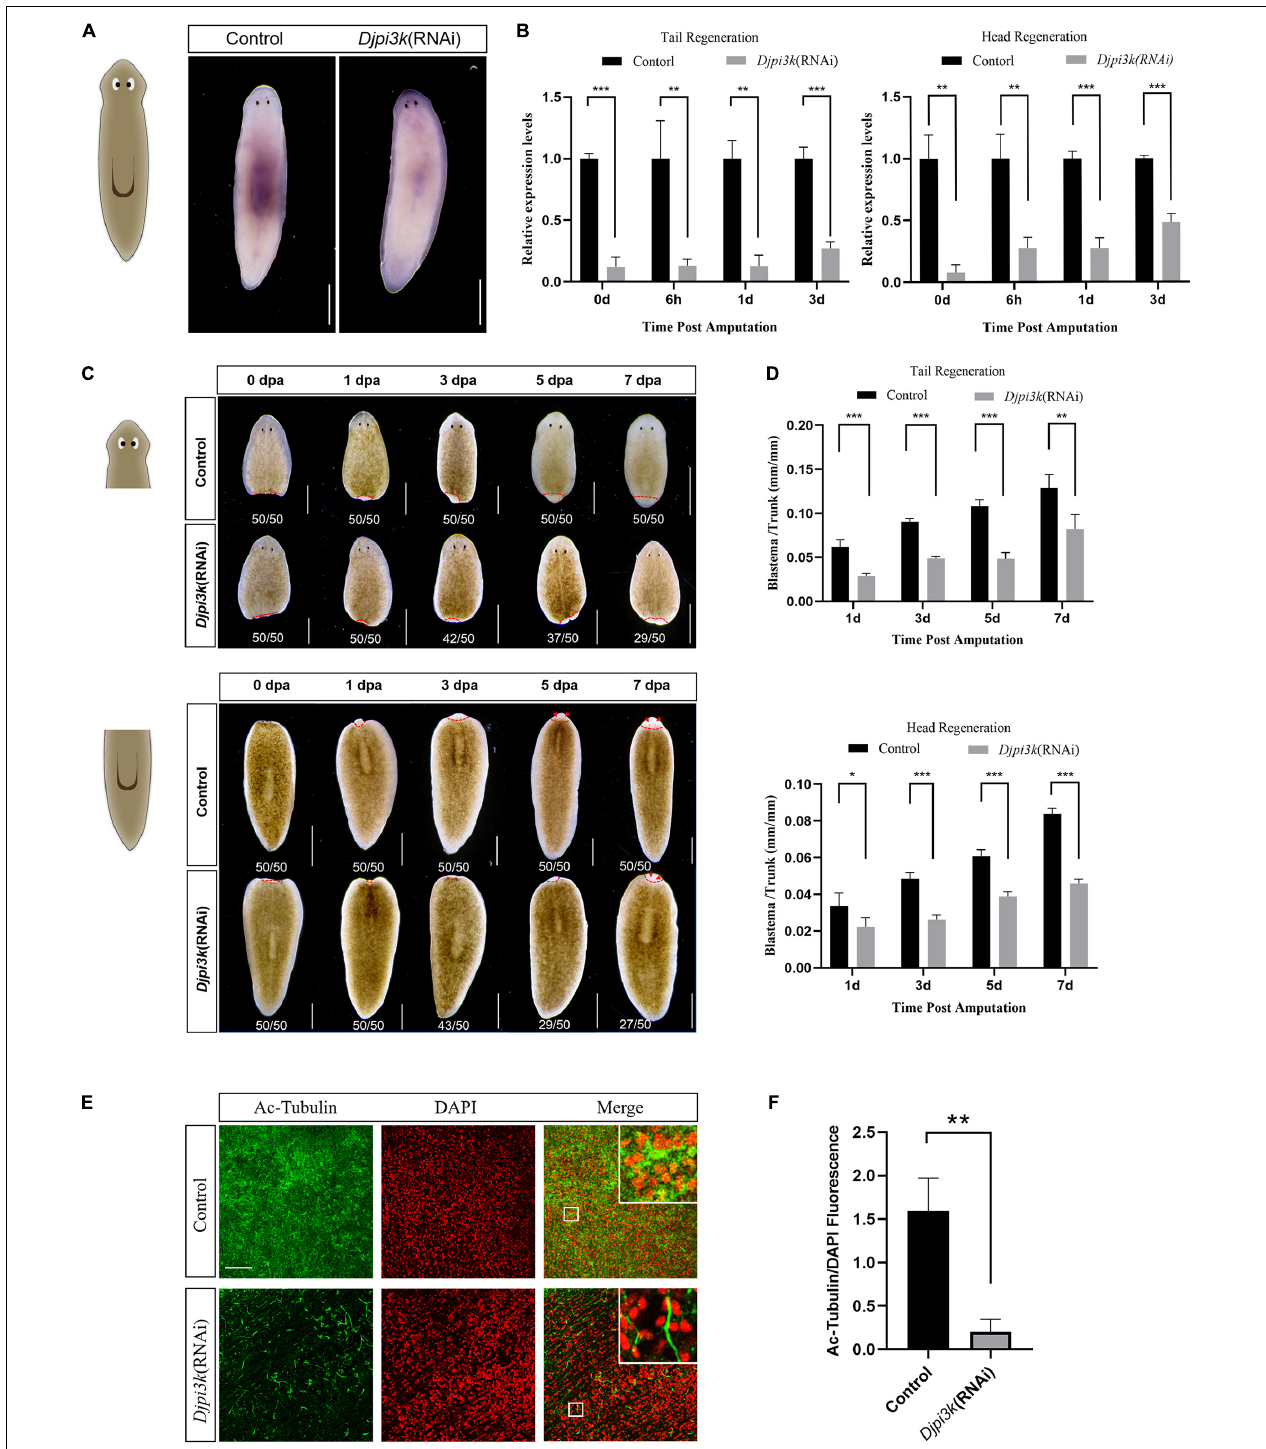
FIGURE 4 | Effect of Djpi3k RNAi knockdown on planarian regeneration and homeostasis. (A) RNAi efficiency was verified in intact animals by WISH using an antisense Djpi3k probe. Scale bar = 1 mm. (B) RNAi efficiency was examined during planarian regeneration by qRT-PCR assay. ** P < 0.01 and *** P < 0.001, by the Student’s t -test. (C) Dorsal images of regenerating trunk fragments from the control and Djpi3k (RNAi) animals at 0, 1, 3, 5, and 7 days post amputation. Newly-regenerated photoreceptors are indicated with red arrows. Scale bar = 1 mm. (D) Quantification analysis of blastema growth. The length of the regenerated blastema was measured and normalized to the whole-body length of the trunk. * P < 0.05, ** P < 0.01, and *** P < 0.001, by the Student’s t -test. (E) Immunostaining of the ventral cilia using an anti-Ac-Tubulin antibody (green). DAPI is used to label the nucleus (red). Magnified images are shown in the right corner. Scale bar = 100 µ m. (F) Quantification analysis of cilia density using the green/red fluorescence intensity ratio. ** P < 0.01, by the Student’s t -test.